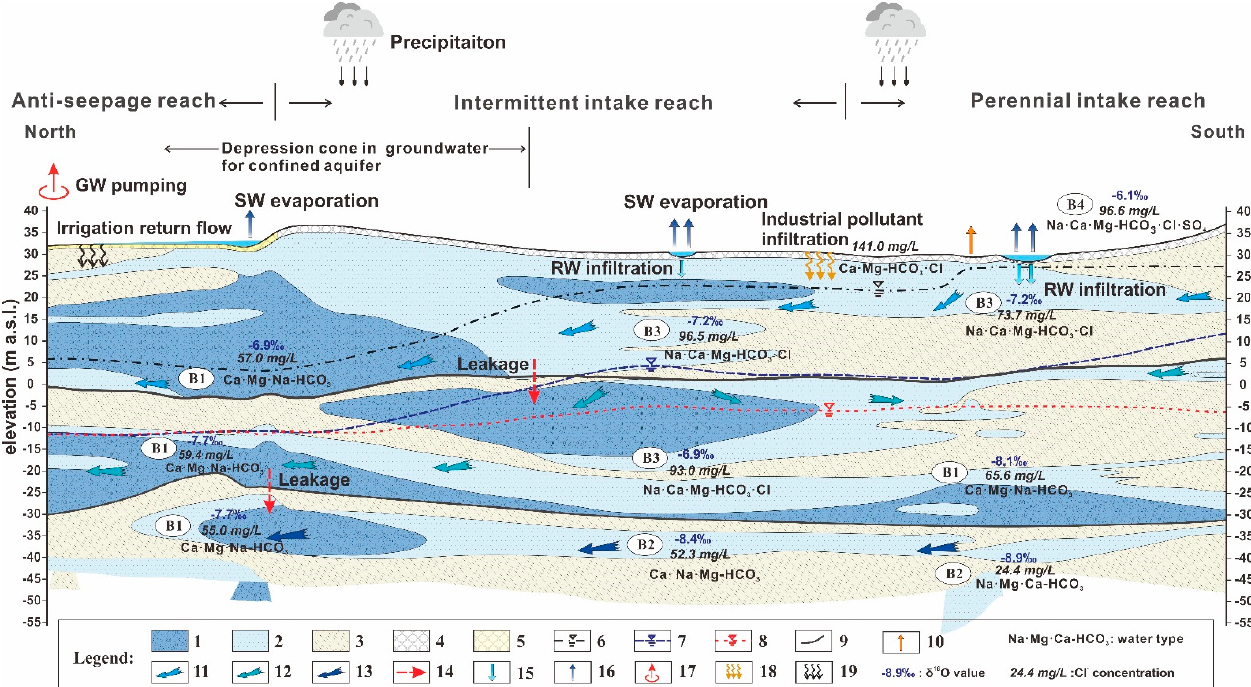
Figure 10. Conceptual model of groundwater flow system underlain the Chaobai River. Explanation: (1) gravel; (2) fine sand; (3) silty clay; (4) backfilled soil; (5) compacted clay; (6) groundwater level of 30-m depth aquifer; (7) groundwater level of 50-m depth aquifer; (8) groundwater level of 80-m depth aquifer; (9) boundary of aquifers; (10) groundwater direct evaporation; (11) groundwater flow direction in 30-m depth aquifer; (12) groundwater flow direction in 50-m depth aquifer; (13) groundwater flow direction in 80-m depth aquifer; (14) leakage recharge; (15) reclaimed water infiltration; (16) surface water evaporation; (17) groundwater pumping; (18) industrial pollutant infiltration; and, (19) irrigation return flow. SW: surface water; RW: reclaimed water; B1, B2, B3, and B4 represent the clusters generated by HCA using hydrochemistry data (Figure 8).